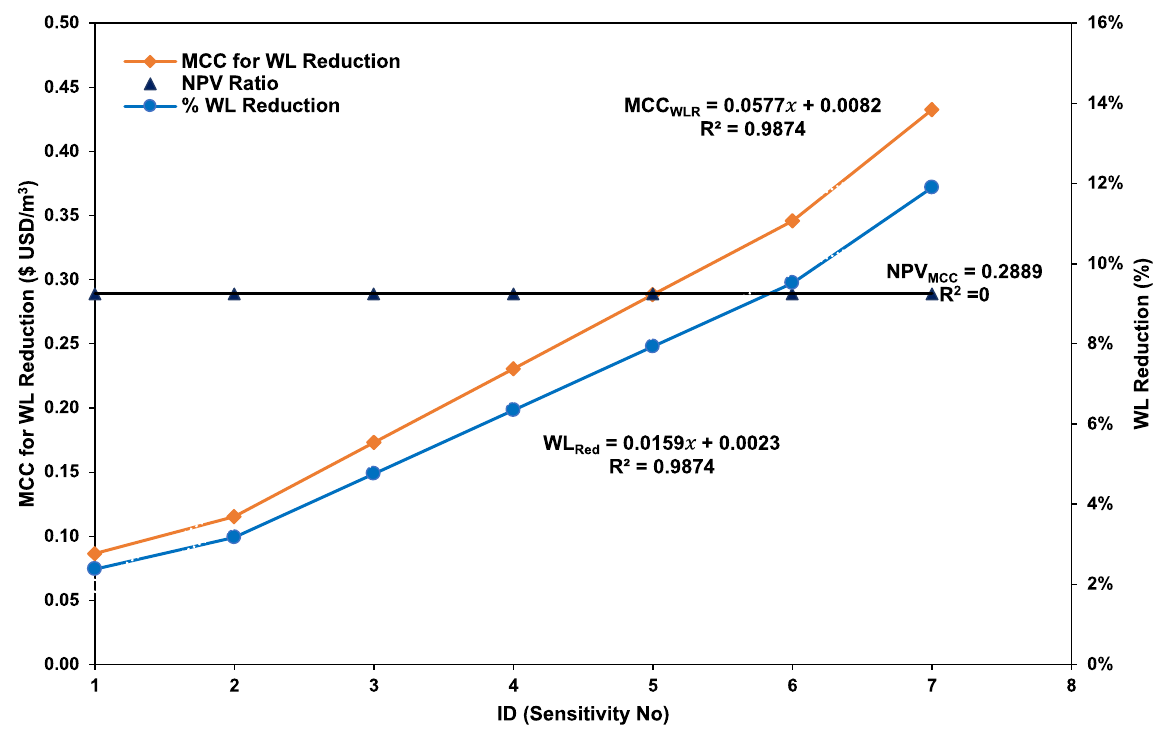
Figure 7. Social capital investment intervention strategy for the social capital investment intervention strategy program. MCC: marginal cost of capital, NPV: net present value, WL: water loss.